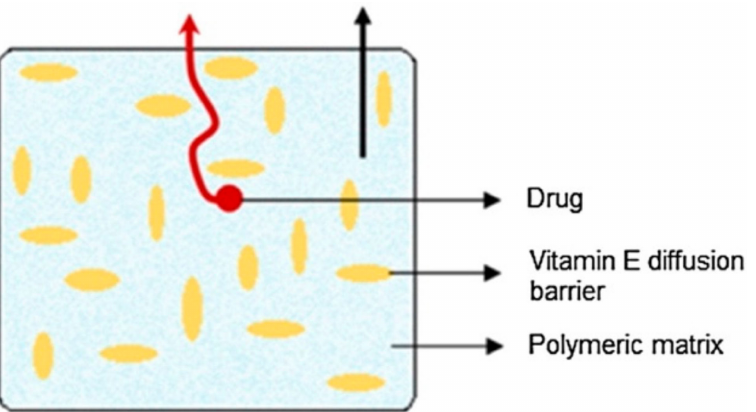
Figure 3. Vitamin E effect on drug diffusion through the polymeric matrix of a CL. Reproduced with permission from [53], @Copyright 2015,